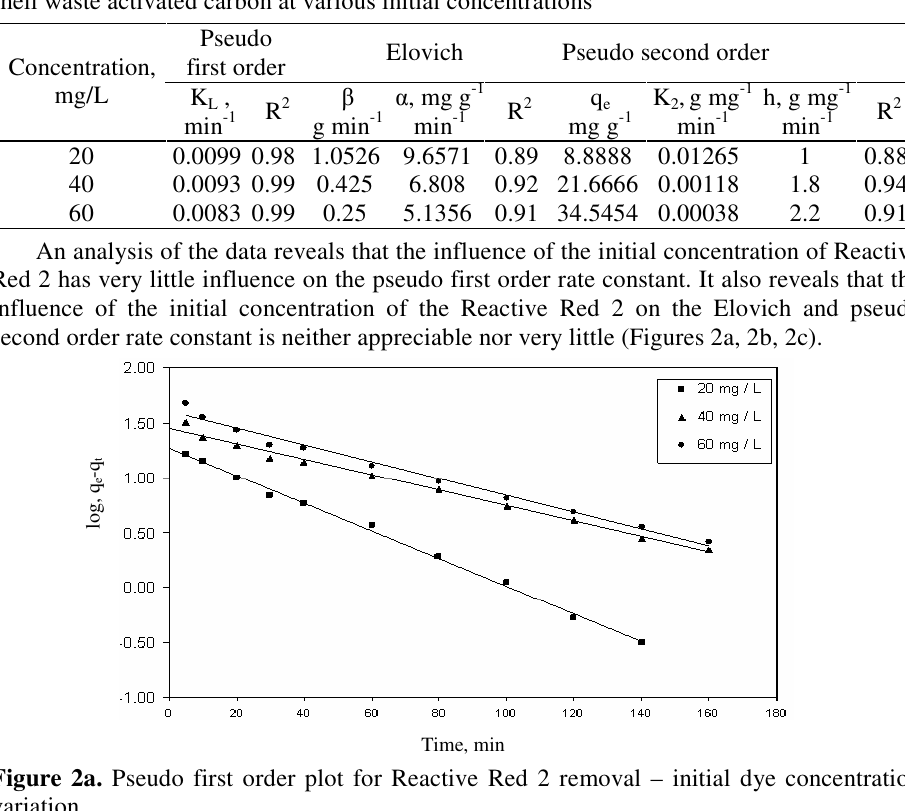
Table 1. Rate parameters for the adsorption of Reactive Red 2 onto Pongamia pinnata seed